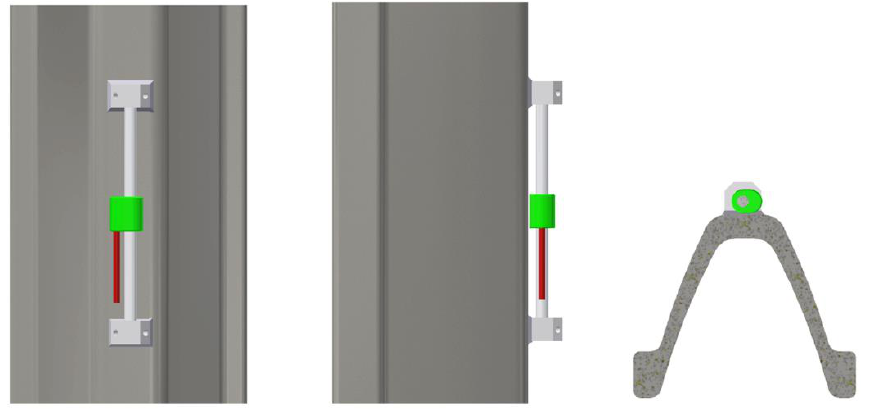
Figure 15. The section of the V29 profile with wire strain gauge.